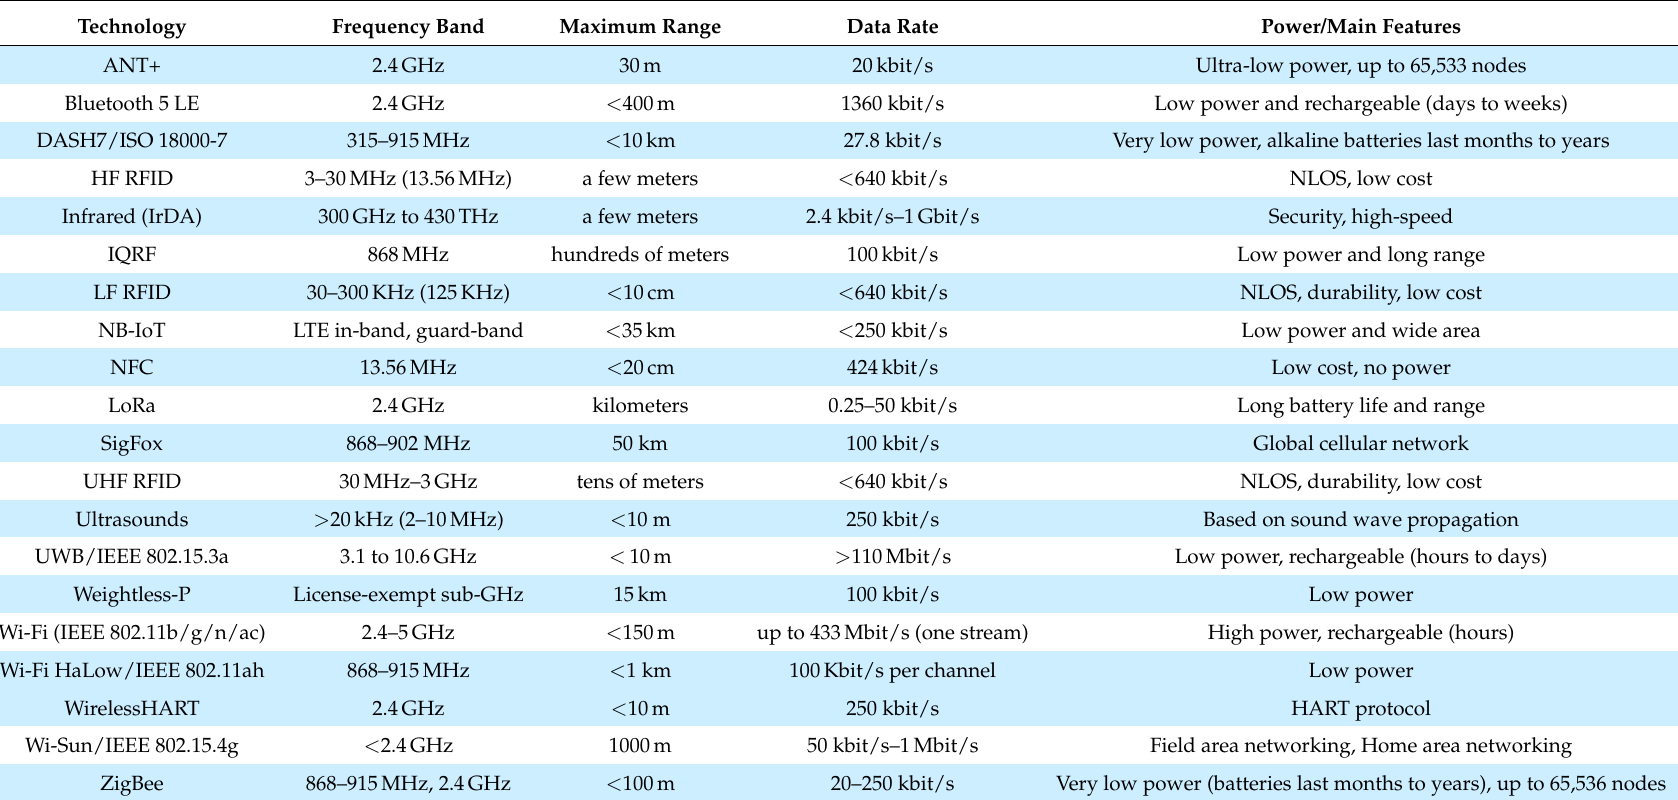
Table 2. Main characteristics of the most relevant communications and identification technologies for smart